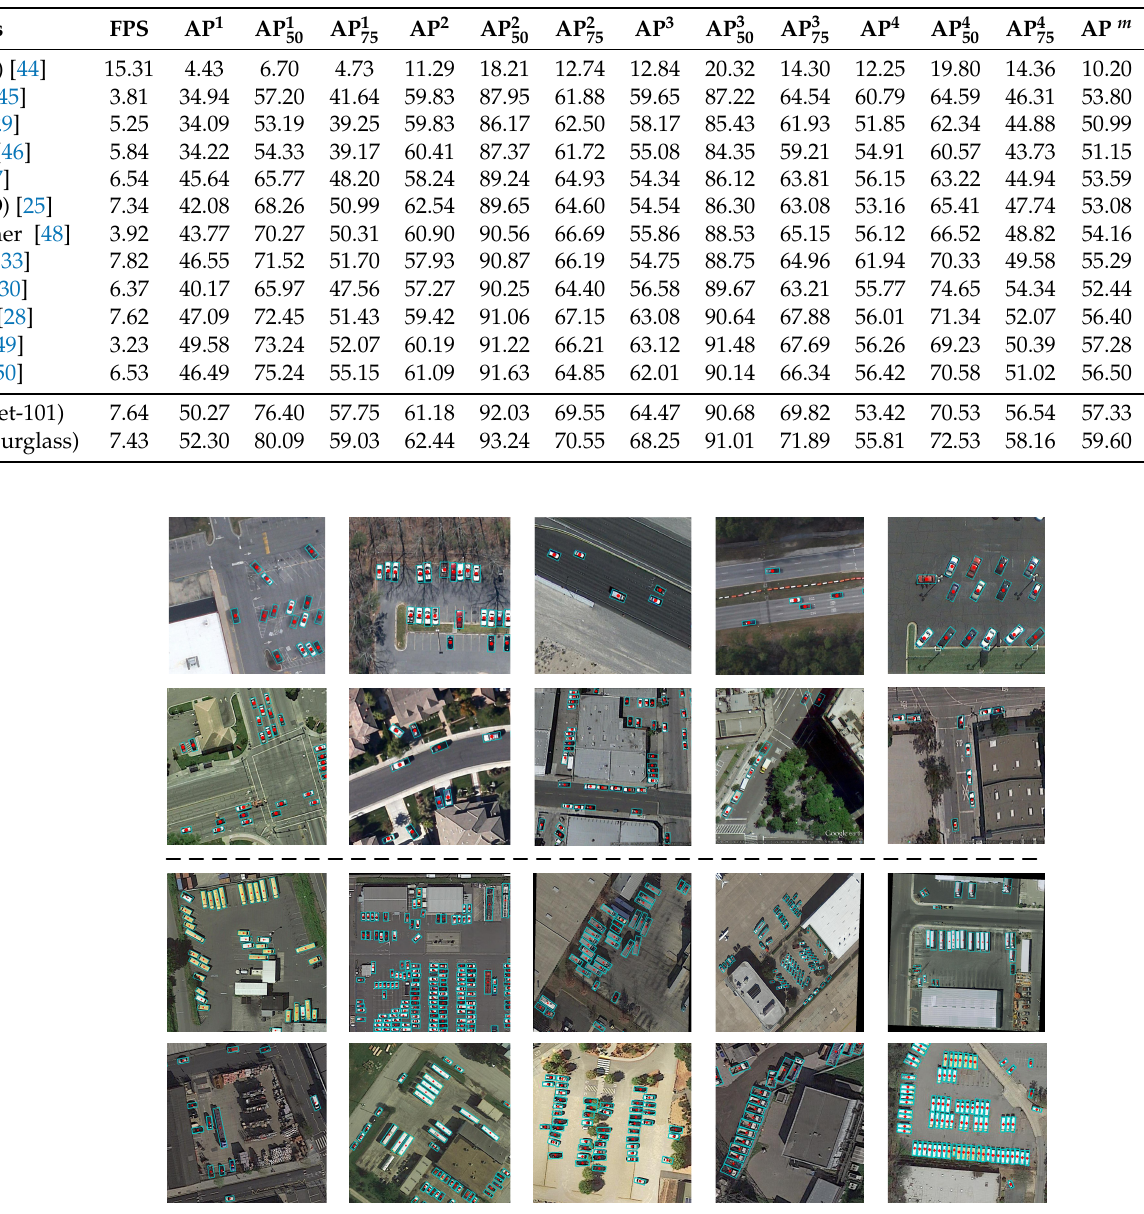
Figure 11. The figure shows some examples of our proposed SR-Net for vehicle detection in any direction. The first two rows visualize the test results of UCAS-AOD in the UCAS-AOD dataset. The last two rows visualize the test results in the DOTA dataset. As can be seen, vehicles of multiple sizes parked in multiple directions can be detected, and accurate bboxes are obtained. The effect is better when viewed in a larger